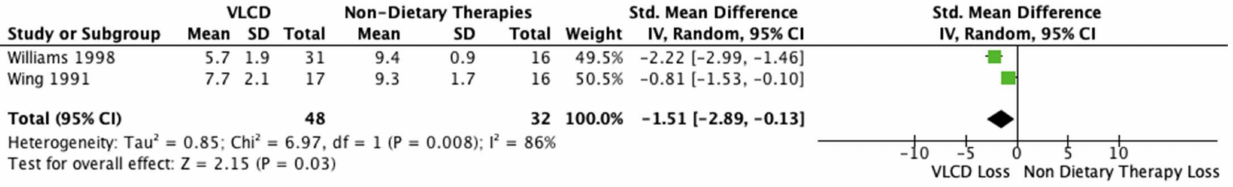
Figure 9. Forest plot comparing fasting glucose levels after VLCD and non-dietary therapies [22,50].